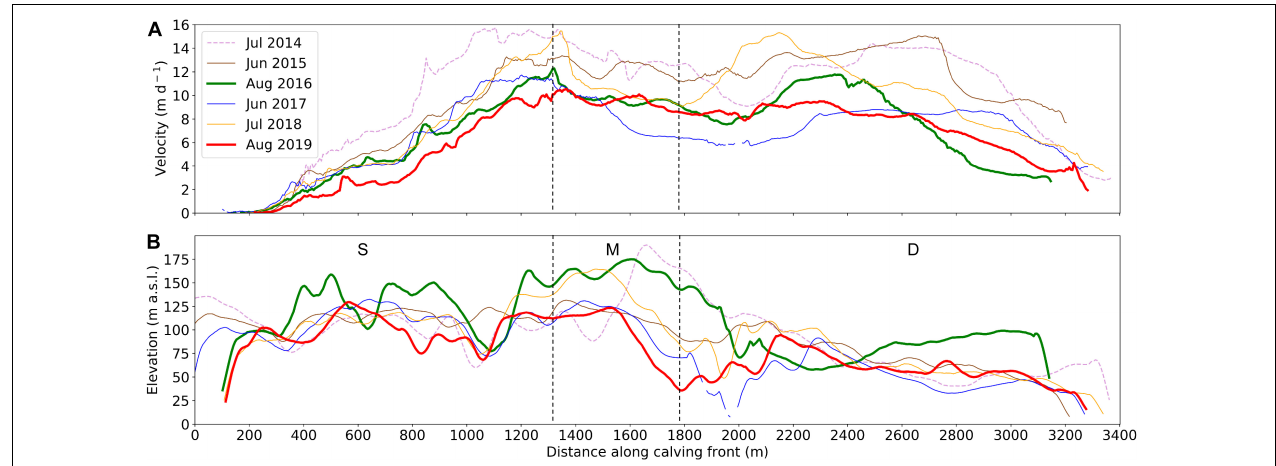
FIGURE 11 | (A) Velocity and (B) elevation along the calving front during each field period as extracted from the TRI measurements. Data from field campaigns later in the melt season (which typically have higher calving activity) are indicated by thick